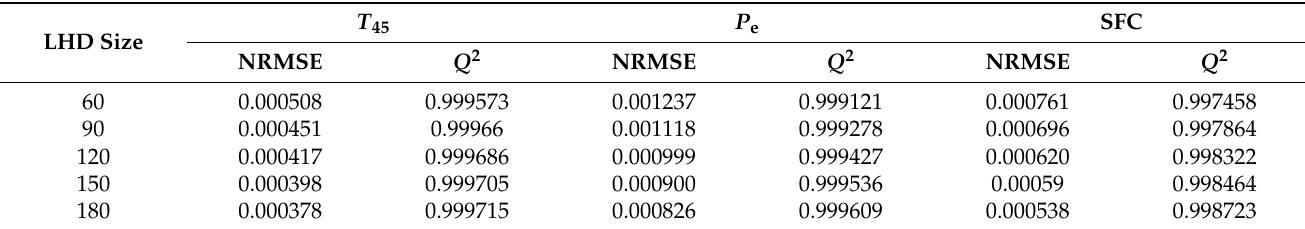
Table 4. Mean values of NRMSE and Q 2 for GPMs of three PMs obtained by 30 LHD replications for each size in (cid:60) . LHD